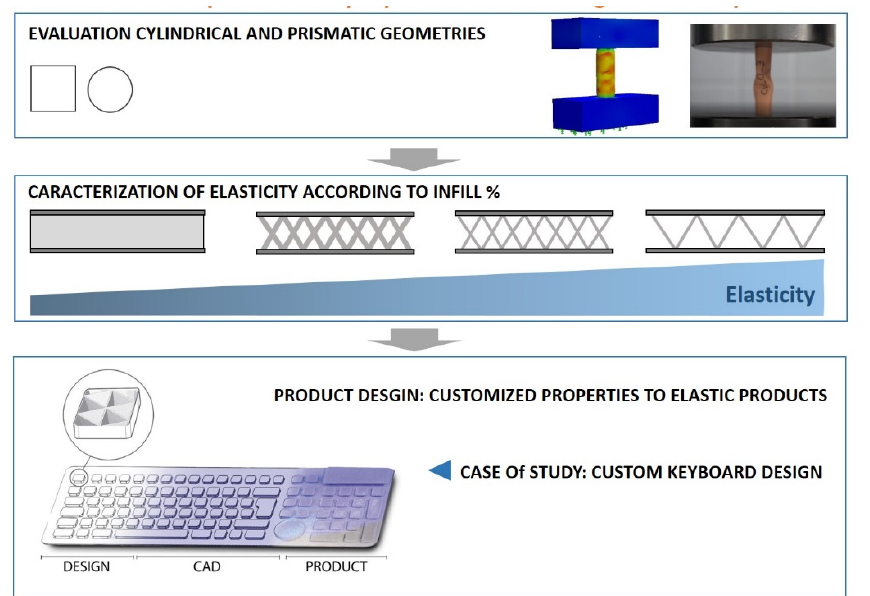
Figure 1. Scheme of the research and procedure for the application of research to the design of flexible or elastic products.